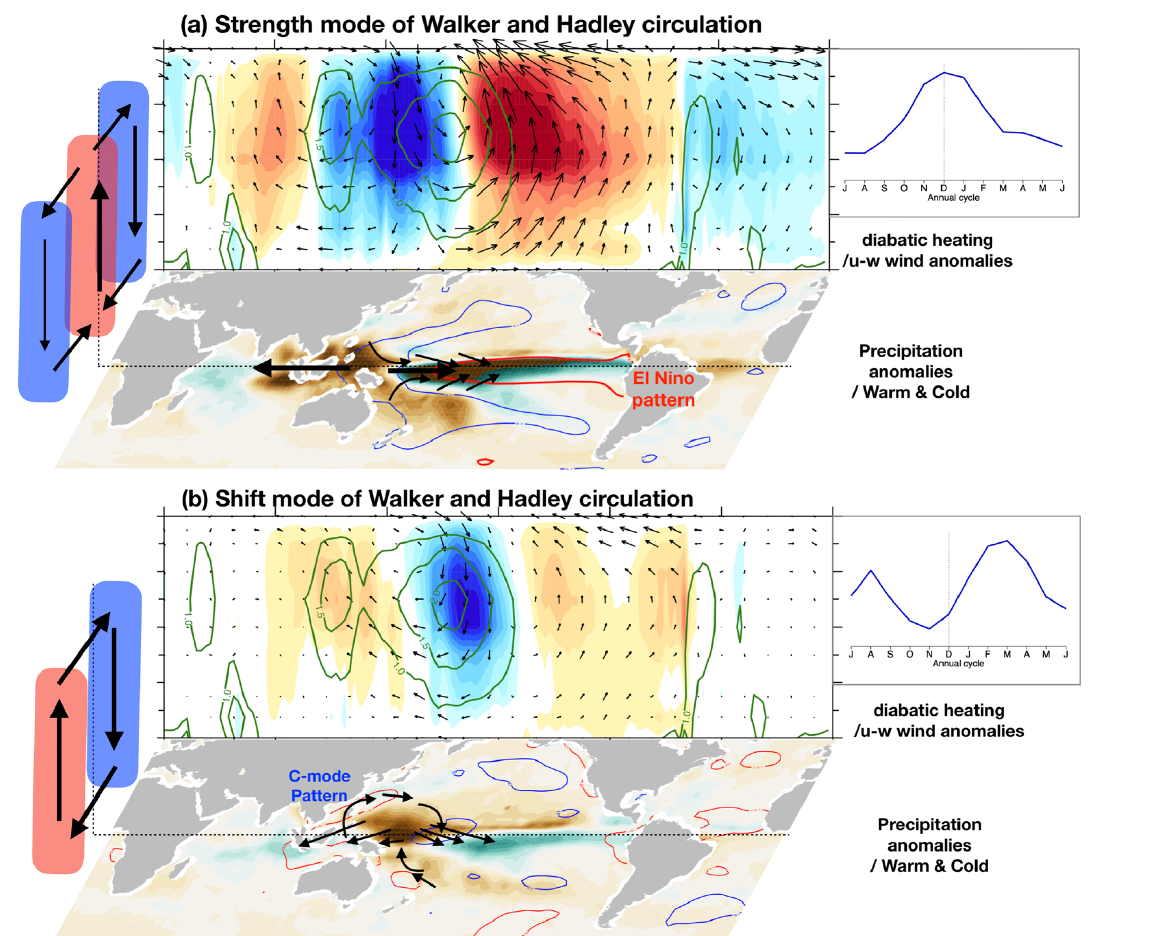
Figure 6. Schematic diagram showing the strength and spatial shift of Walker and Hadley circulations. (a) Walker and Hadley circulation strength mode (WC1&HC2) and (b) shift mode (WC2&HC1) on interannual timescale. Panel (a) shows the longitude–height structure averaged over tropics (15 ◦ S–15 ◦ N) for the diabatic heating anomalies (shading), climatological diabatic heating (green contours) and u – w wind anomalies (vectors). The bottom horizontal map shows the precipitation anomalies (shading) and warm/cold SST anomalies (red/blue contours). The schematic on the left indicates the anomalous Hadley circulation. All plots are based on the regressed anomalies against the Walker circulation variability (WC1 in a and WC2 in b ). The upper right panels show the annual cycle of circulation variability.